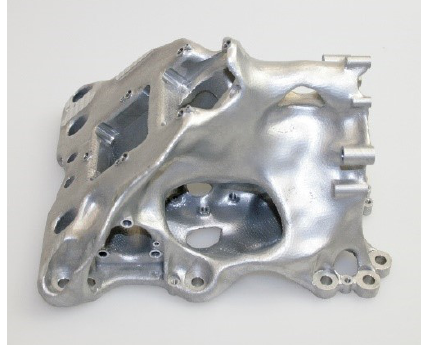
Fig. 4. Topology optimized optical housing, made by AM out of